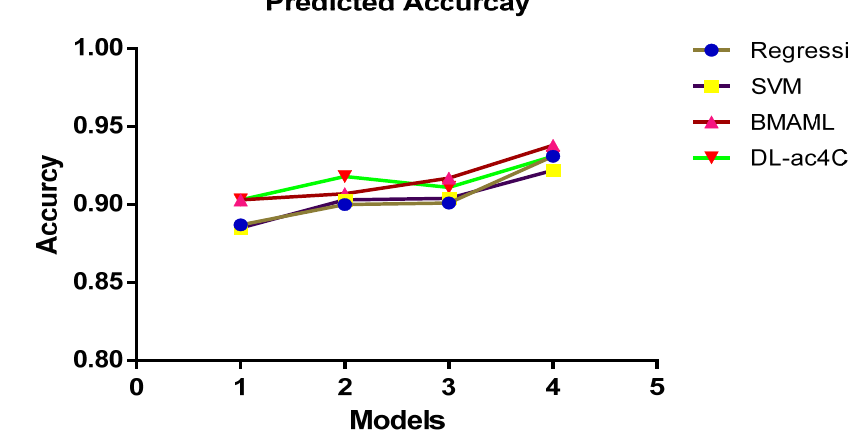
Figure 2. Predicted accuracy of models.